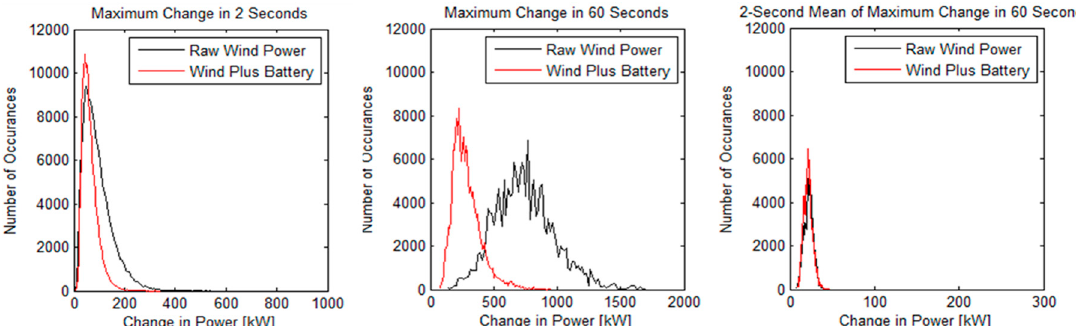
Figure 13. Histograms of three metrics related to the power purchasing agreement between the HRD wind farm and the utility, HELCO. The metrics are the maximum change in power output over 2 s ( left ), the maximum change in power output over 60 s ( middle ), and the one-minute average of the maximum power output over 2 s ( right ). The black (red) lines indicate metrics calculated from data when the BESS was inactive (active). The data was collected from 8 a.m. to 6 p.m. on 4/5/2013.